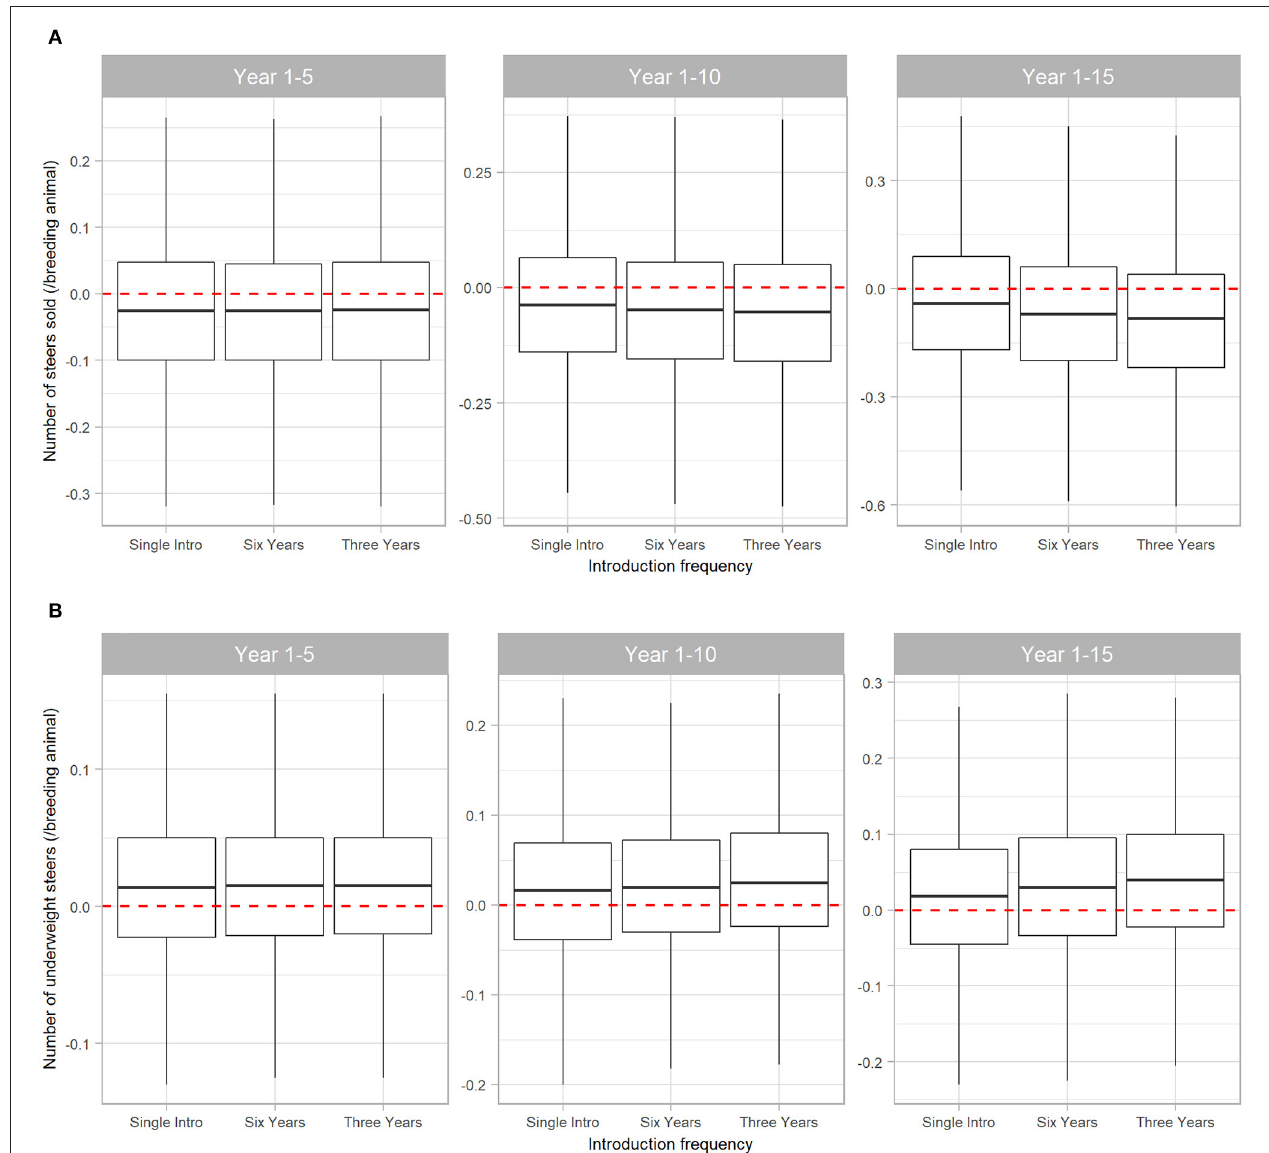
FIGURE 5 | Boxplot illustrating the cumulative effect of BVDV introduction frequency on production outputs relating to steer sales in a simulated beef herd. The values depict the production loss for BVDV introduction compared to a disease-free herd. The dotted red line highlights zero, which would represent “no difference” between the disease-free scenario and the scenarios with BVDV. Values either side of the line indicate the impact of BVDV on the number of steers sold (A) and the number of steers sold that were too lightweight to qualify for a price premium (B) /breeding animal. Boxes represent the 25 and 75% percentiles while whiskers represent the 2.5 and 97.5% percentiles. Outliers removed for improved scale and